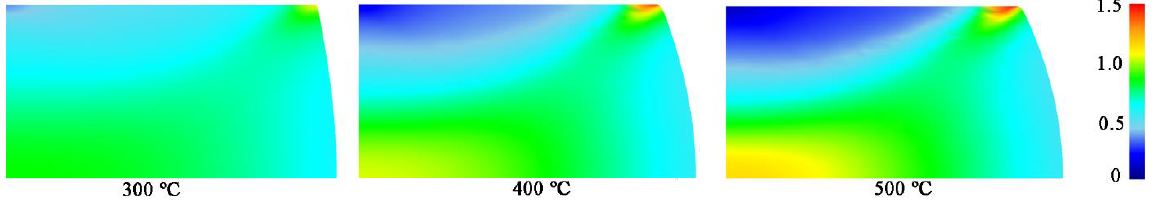
Figure 8. Accumulated strain distribution in the AlMg6/10% SiC MMC specimens under 50% compression at 300, 400, and 500 °C.